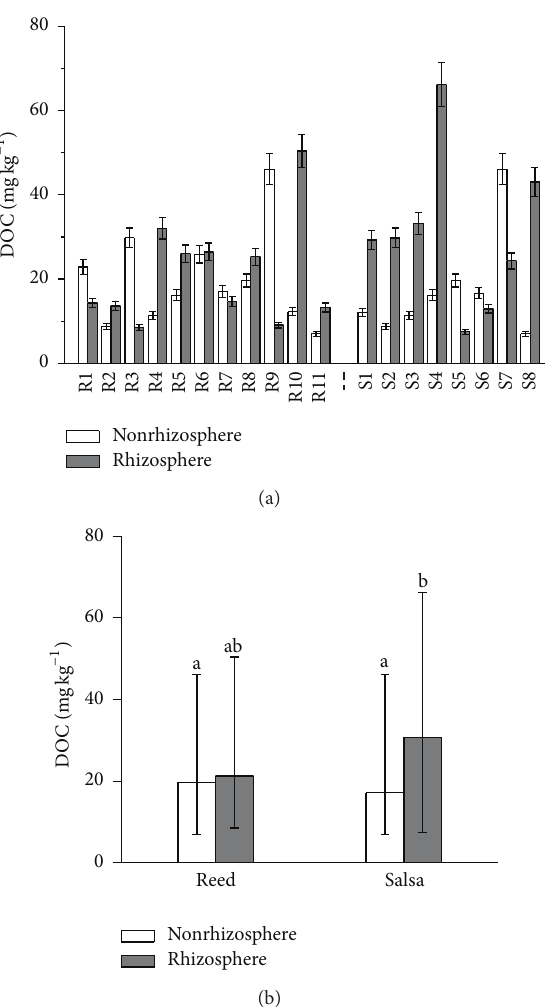
Figure 7: DOC contents in rhizosphere and nonrhizosphere soils of reed and salsa. The columns represent the average contents and the error bars in left part represent the uncertainty U of TOC contents and in the right part represent the variation range. The lettersrepresentthedifferencesofsoilTOCcontentsatthe0.05level.